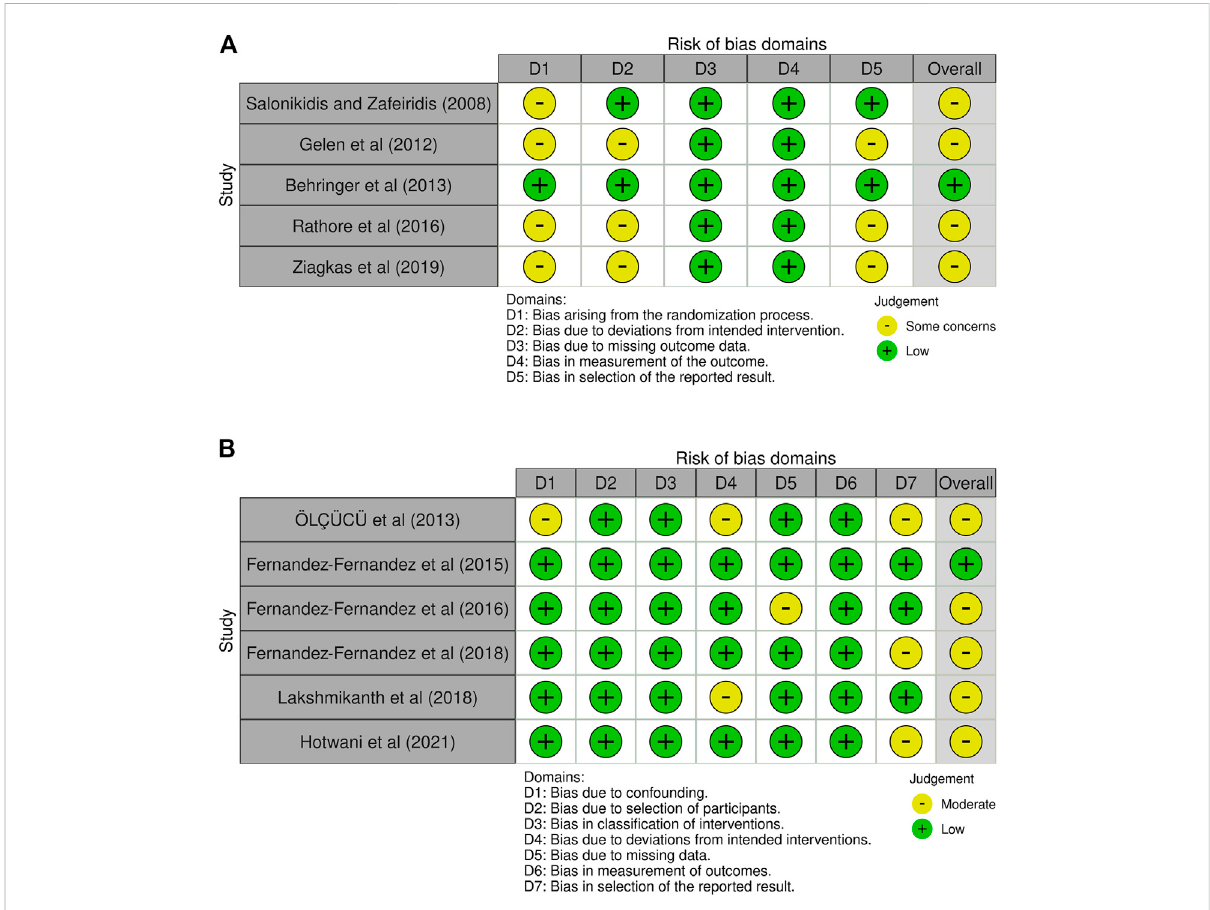
FIGURE 2 Risk of bias. (A) Results for RCTs, (B) results for non-RCTs. *Created using Robvis (visualization tool): McGuinness and Higgins